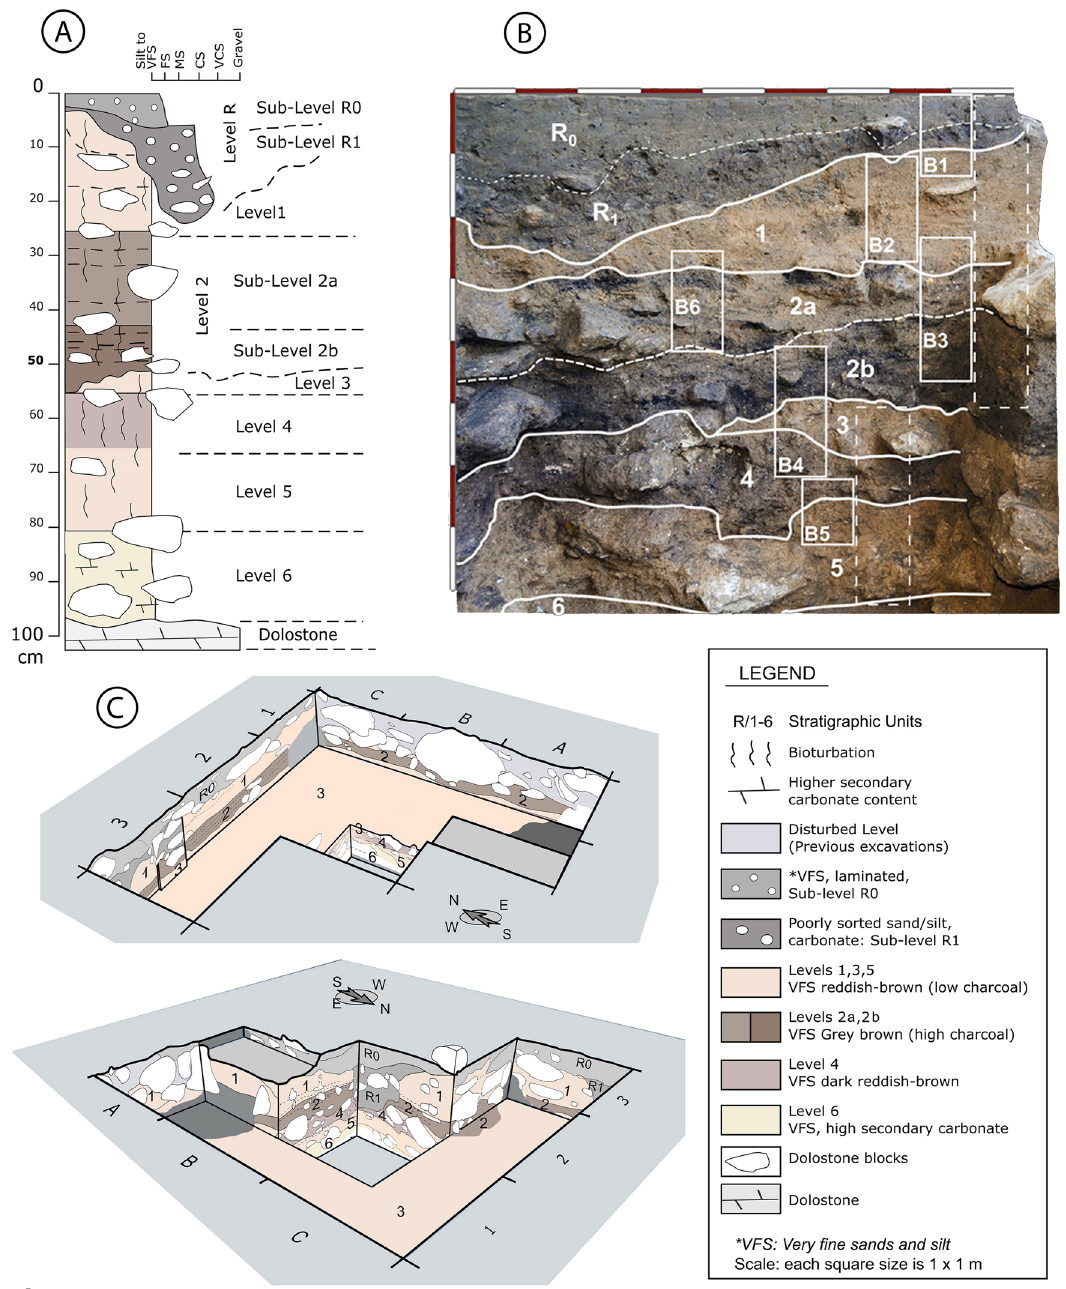
Figure 4. ( A ) Stratigraphic units defined in the Peña Capón site. Note that the main differences between layers are due to variations in organic matter and secondary carbonate content. ( B ) Stratigraphic sequence recorded in the western profile of square 2B showing sample location for micromorphology (B1–B5) and sedimentology (dashed-lines rectangles). ( C ) Views of the excavation profiles at Peña Capón showing the different distribution and geometry of the stratigraphic units defined in the